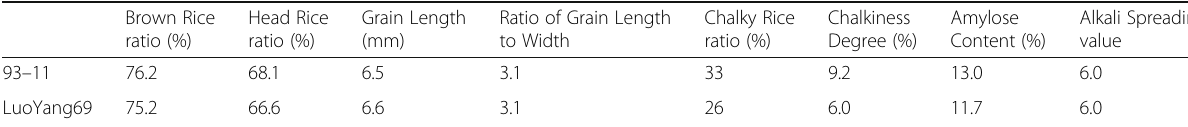
Table 3 The rice quality traits of LuoYang69 and 93 – 11 Brown Rice ratio (%)